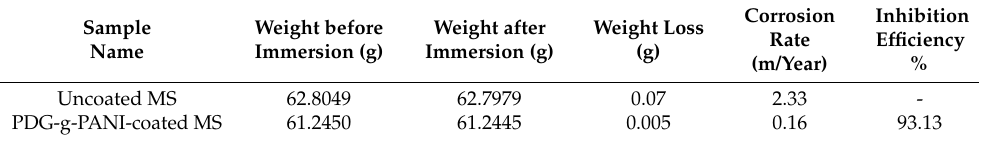
Table 7. Weight of uncoated and coated MS before and after immersion, with corresponding corrosion rate and inhibition efficiency of